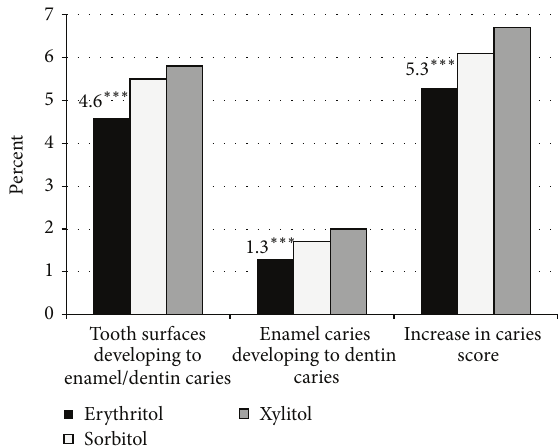
Figure 7: Percentage of tooth surfaces developing into enamel or dentin caries, percentage of enamel caries developing into dentin caries, and percentage of surfaces with an increase in caries score (increase in caries score is transition from any caries score to increase in score of 1 or more) over a 3-year period in a child cohort consuming erythritol-, sorbitol-, or xylitol-containing can- dies. From Honkala et al. [37]. ∗∗∗ 𝑝 < 0.001 when compared to sorbitol using Fisher’s exact test (two-tailed).